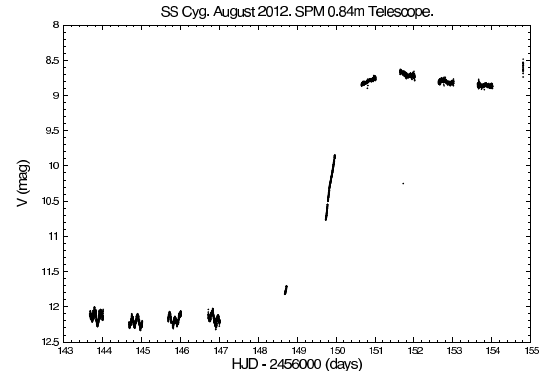
Figure 2: V photometry of SS Cygni in quiescence, rise and outburst, August 2012.